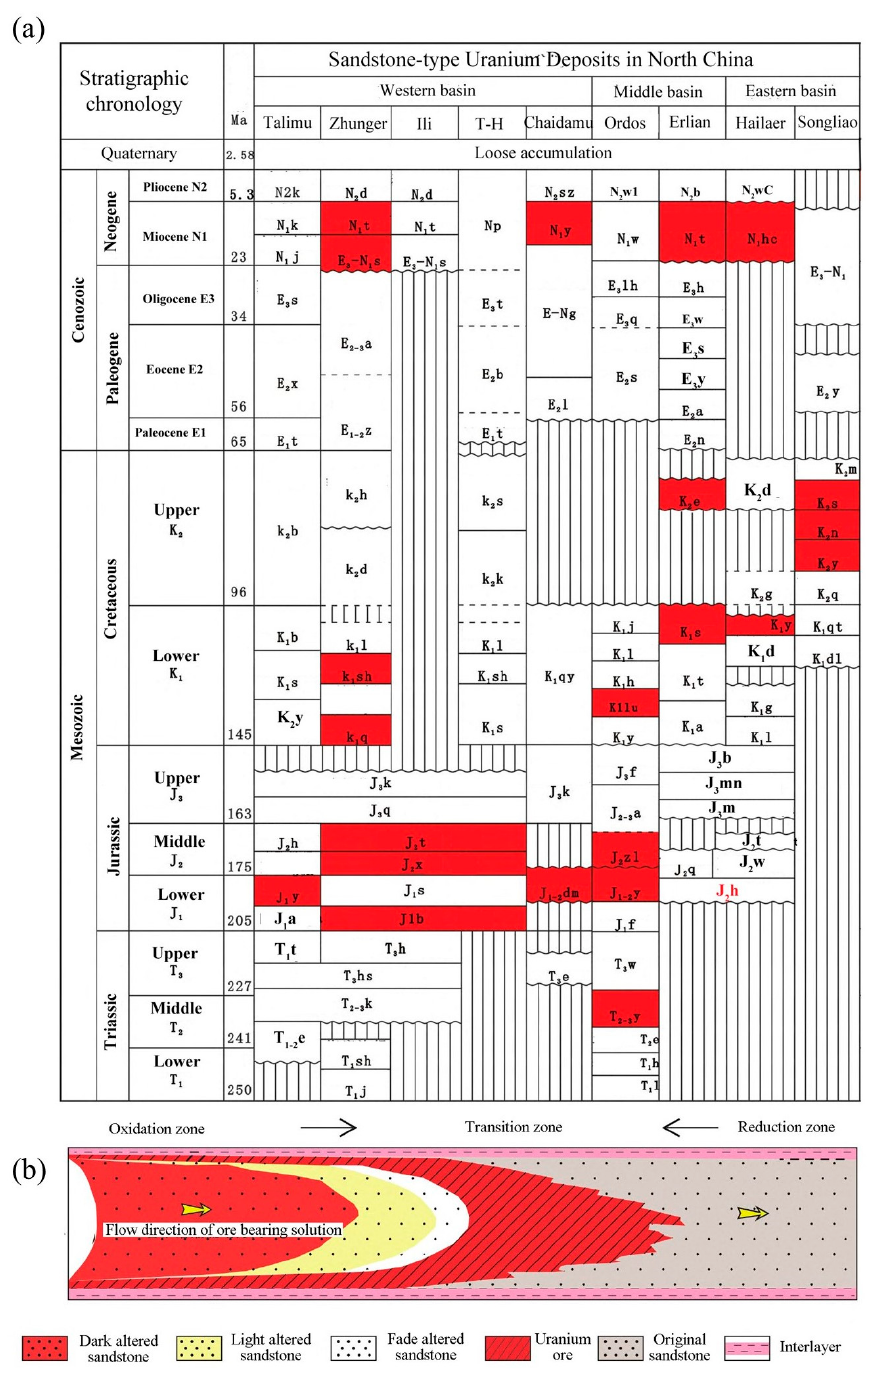
Figure 2. Stratigraphic chronology of stone-type uranium deposits in northern China ( a ) and a sketch of the oxidation-reduction zone ( b ) in the metallogenic belt. T-H means Turpan-Hami Basin. Multilayer aquifer systems are universal in all these deposits [47–50]. For example, the Qianjiadian uranium deposit in the Songliao Plain has four aquifers with an average thickness of 55 m [48], and the Shihongtan deposit in the Turpan-Hami Basin has seven